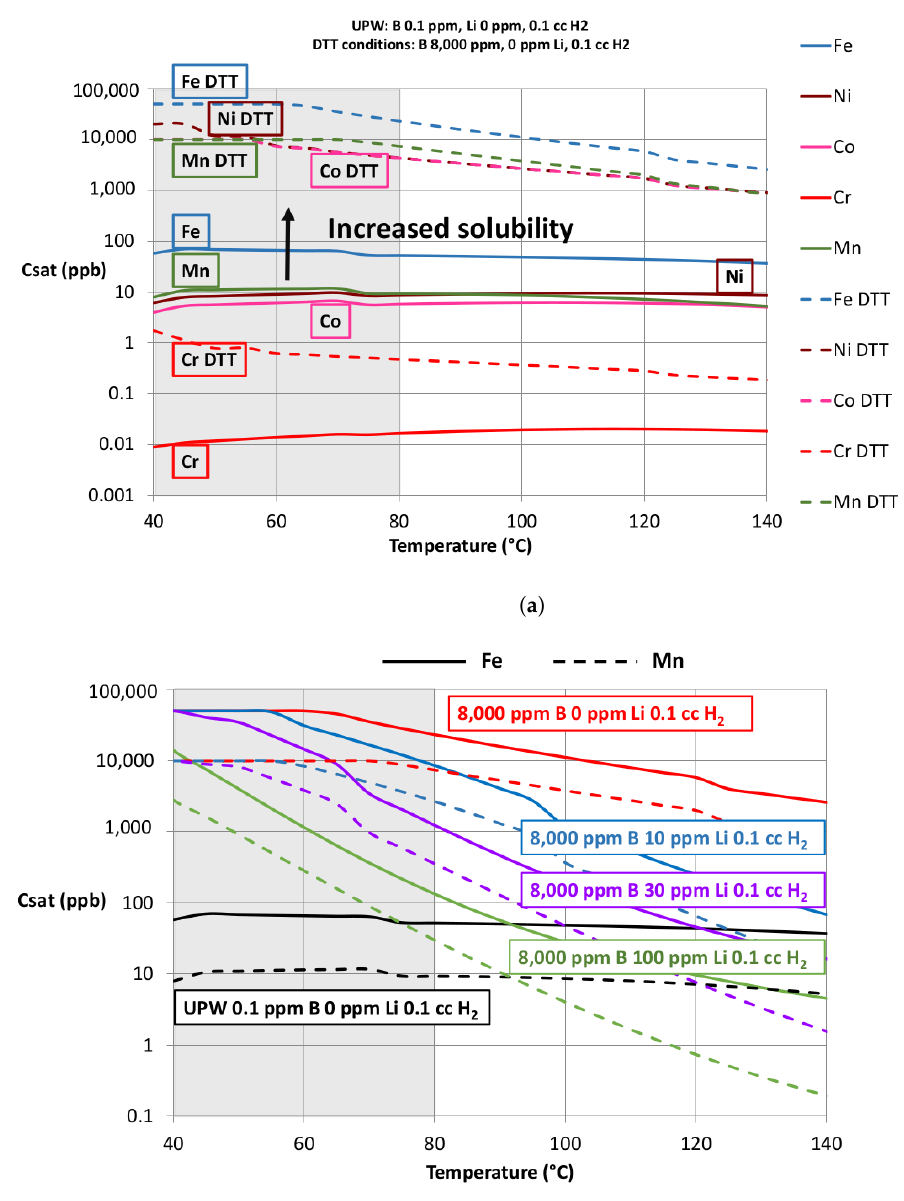
Figure 7. Solubility data obtained from POTHY: ( a ) the solubility of cations in a UPW environment (solid lines) vs. borated water (8000 ppm B) with no LiOH addition (dashed lines) to simulate DTT VV cooling circuit. ( b ) Comparison of the solubility of Fe (solid line) and Mn (dashed line) in the case of a borated water solution with the addition of 0, 10, 30, and 100 ppm Li as